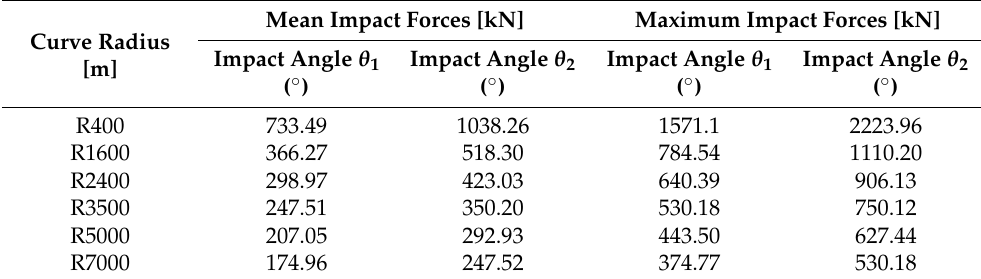
Table 6. Impact forces considering suspension